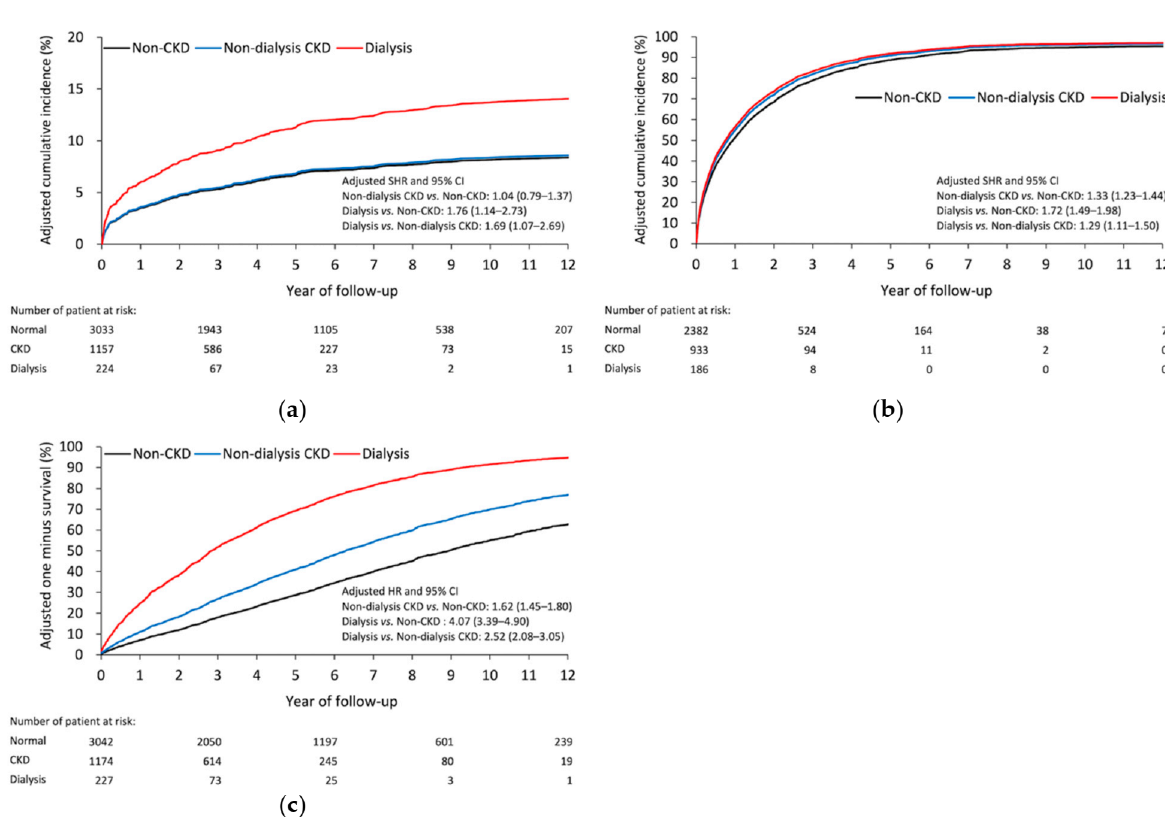
Figure 2. Distribution of renal function status for patients with diabetes who received shoulder arthroplasty from 1998 to 2013. The proportion of patients with non-dialysis CKD and those requiring dialysis stably increased across the study period ( p -trend < 0.001). CKD, chronic kidney disease.